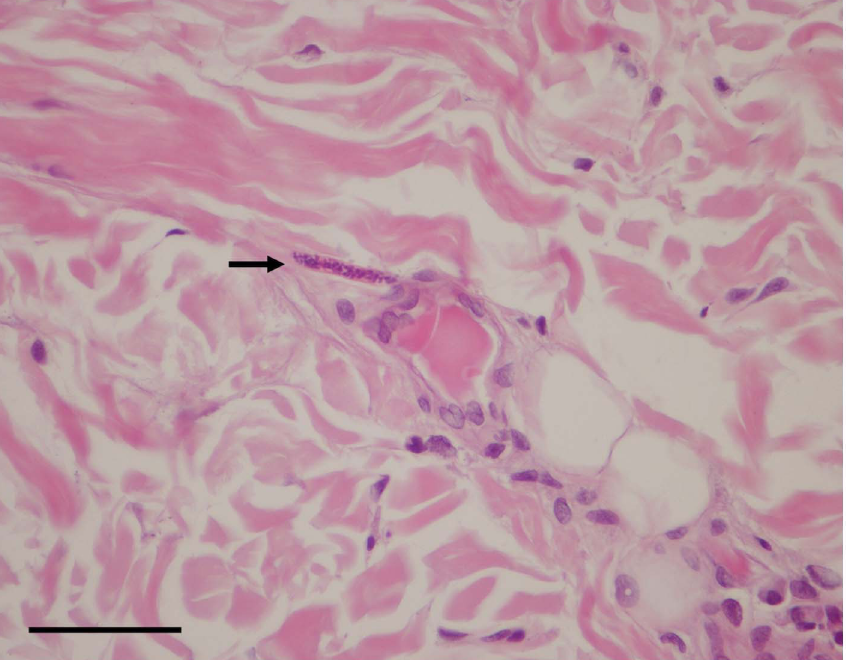
Figure 5. Histology of microfilaria of Onchocercalupi in the skin. Microfilaria of Onchocerca lupi (arrow) detected in biopsied skin. In the interstitium of the dermis. Haematoxylin-eosin stain. Scale bar=50 m